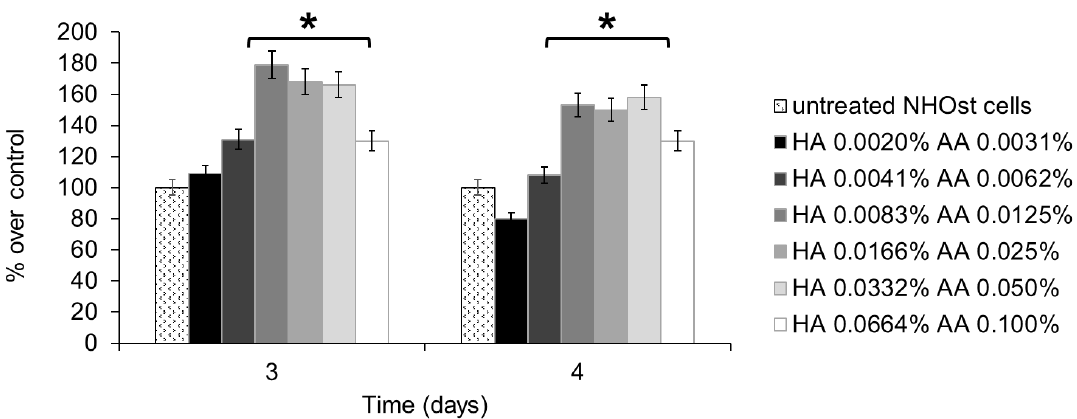
Figure 1. MTT assay performed on NHOst cells after 3 or 4 days of culture, in the presence of different concentrations of HA+AA solutions. Data are expressed as percentage over control, i.e., untreated NHOst cells. Each bar represents the mean of six independent experiments. * p < 0.03. HA: sodium hyaluronate, AA: amino acids.